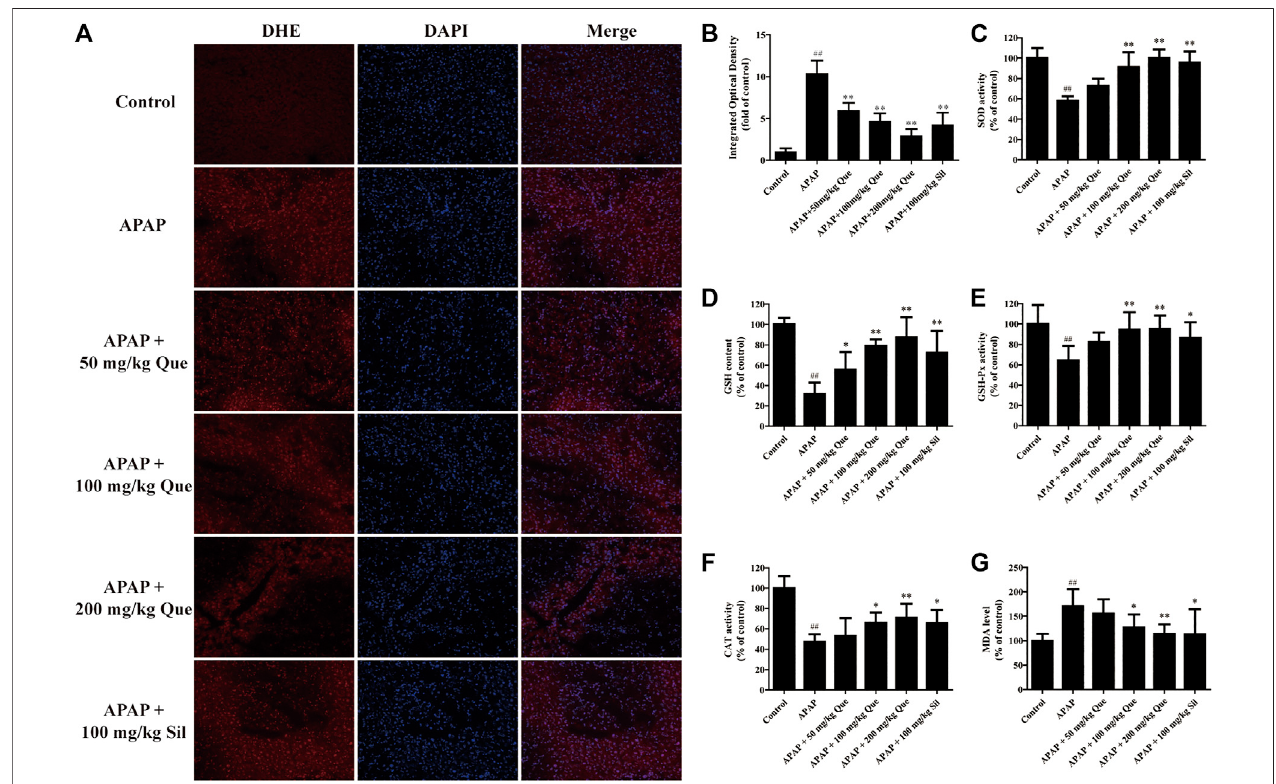
FIGURE4| EffectofquercitrinonAPAP-inducedoxidativestress. (A) ROSfrozensectionsofthelivertissueofmice(DHEstaining200 × ). (B) IODoffrozensections. (C – F) SOD, GSH, GSH-Px, and CAT levels in the liver of mice. (G) MDA content in the liver of mice. The experimental data are expressed as mean ± SD, ## p < 0.01, compared with the control group; * p < 0.05, ** p < 0.01, compared with the APAP